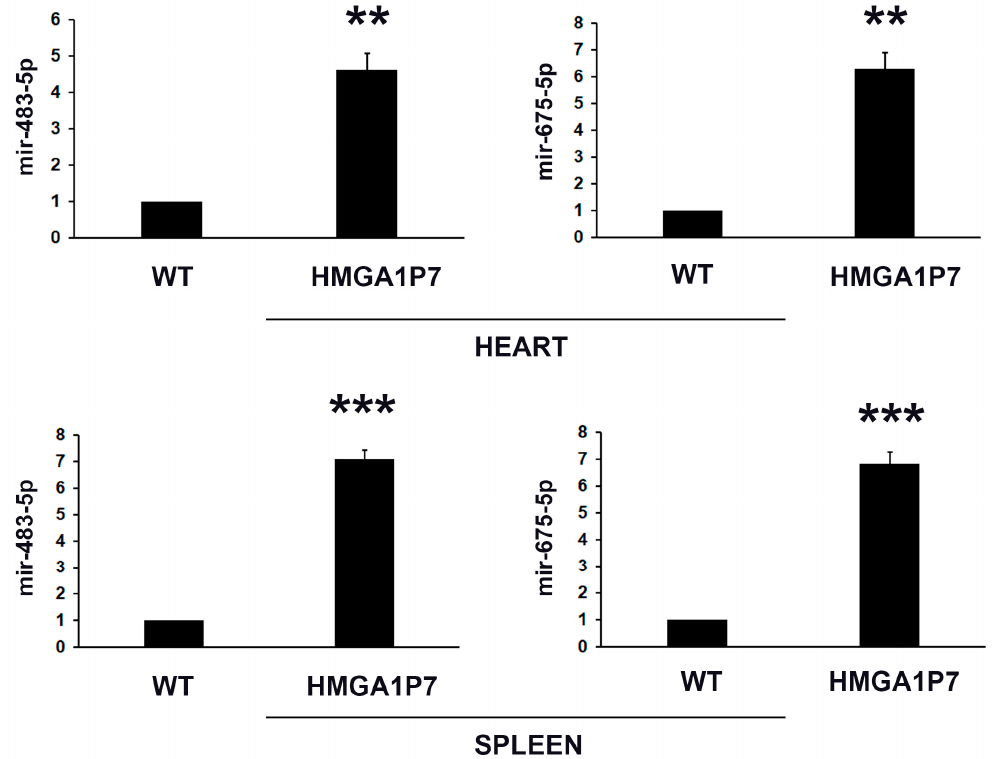
Figure 2. mir-483-5p and mir-675-5p are overexpressed in HMGA1P7 transgenic mouse tissues. qRT-PCR analysis of mir-483-5p and mir-675-5p from hearts (upper panel) and spleens (lower panel) explanted from WT and HMGA1P7 transgenic mice. The results are reported as the mean of values. The error bars represent mean ± SD; *: p < 0.05, **: p < 0.01, ***: p < 0.001 (t test).